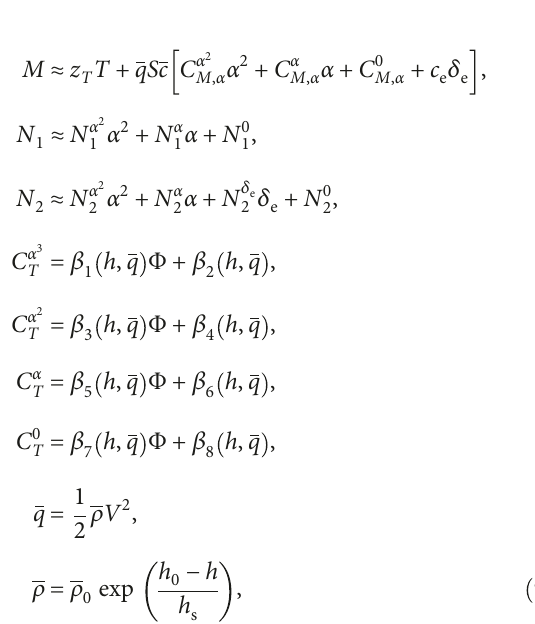
Figure 1: Force map of an AHV